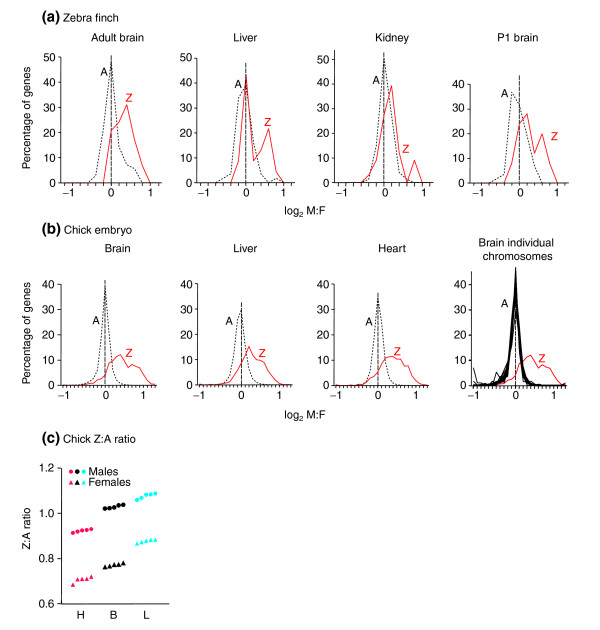
Distributions of male-to-female (M:F) ratios of gene expression based on microarray studies of birds. (a) M:F ratios in zebra finches, in adult brain, liver, and kidney, and brain of post-hatch day 1 (P1). Autosomal genes (A) are represented by the black dotted line, Z genes (Z) by the red line. The vertical dashed line is centered at a M:F ratio of 1 (log2 ratio of 0). (b) M:F ratios of embryonic chick brain, liver and heart. In each case Z genes are expressed at higher M:F ratios than A genes. In (b) the panel on the far right shows distributions for brain of individual chromosomes containing more than 50 genes. In all panels in (a) and (b) the rightmost bin (at the rightmost mark on the abscissa) includes all genes with M:F ratios at that value or greater, and the leftmost bin includes all genes with M:F ratios at that value or smaller. (c) Z:A ratios of five male and five female chicken samples for heart (H), brain (B) and liver (L).